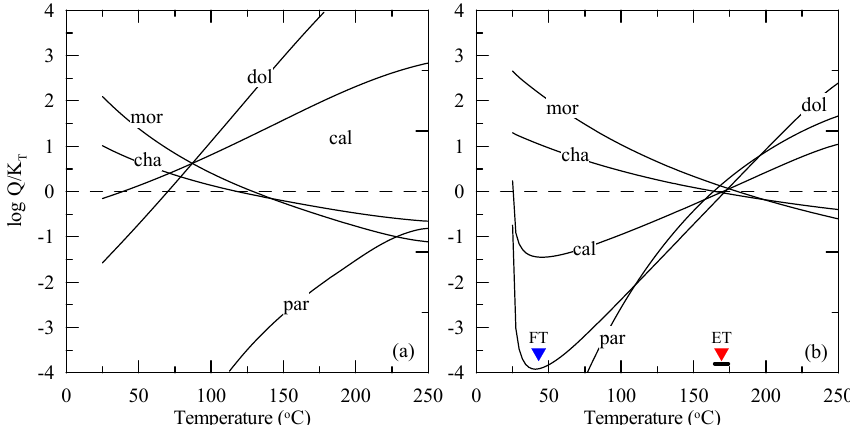
Figure 4. Temperature estimation for Battle Creek hot spring near Preston, Idaho. (a) The log Q/K T curves for minerals calculated using original water chemistry with K feldspar used as a proxy for Al, (b) optimized log Q/K T curves (FT: field temperature (43 ◦ C); ET: estimated temperature (169 ◦ C), the dark horizontal bar below ET represents the ± standard error for the estimated temperature ( ± 5 ◦ C); cal: calcite, cha: chalcedony, dol: disordered dolomite, mor: mordenite K, and par: